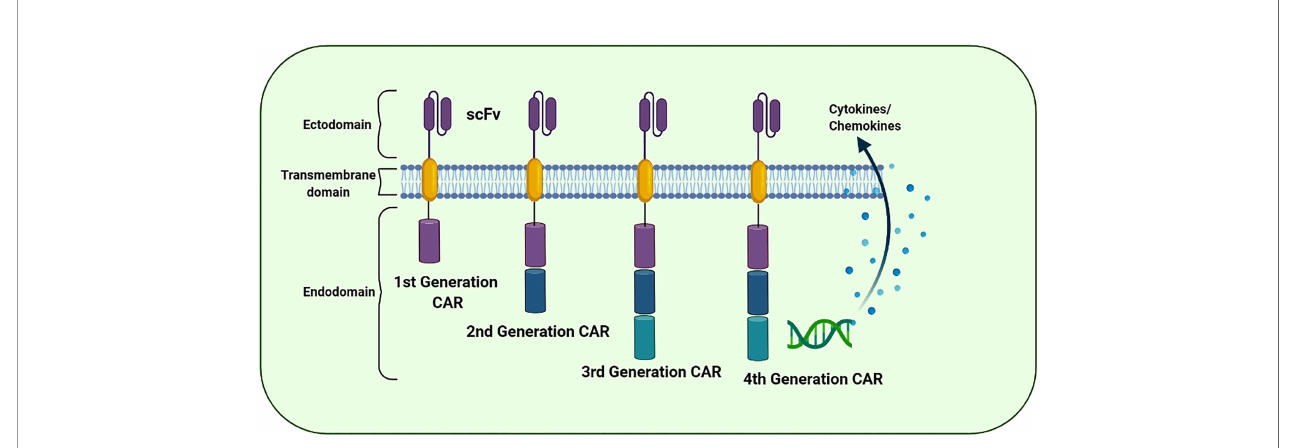
FIGURE 4 | The evolution of the chimeric antigen receptor (CAR) structure over time: The structural components of 1 st , 2 nd , 3 rd , and 4 th generation of CAR. The CAR “ generations ” denote the number and composition of the intracellular signaling domains. The 1 st generation ’ s CARs failed to deliver cell proliferation signals for the retention of anti-cancer potential. However, 2 nd and 3 rd generation CARs have CD28, CD134 (OX40), and CD137 (4-1BB) to promote the anti-tumor potential. The 4 th CAR generation is designed to secrete cytokines to further improvise the therapeutic activity of the CAR-based